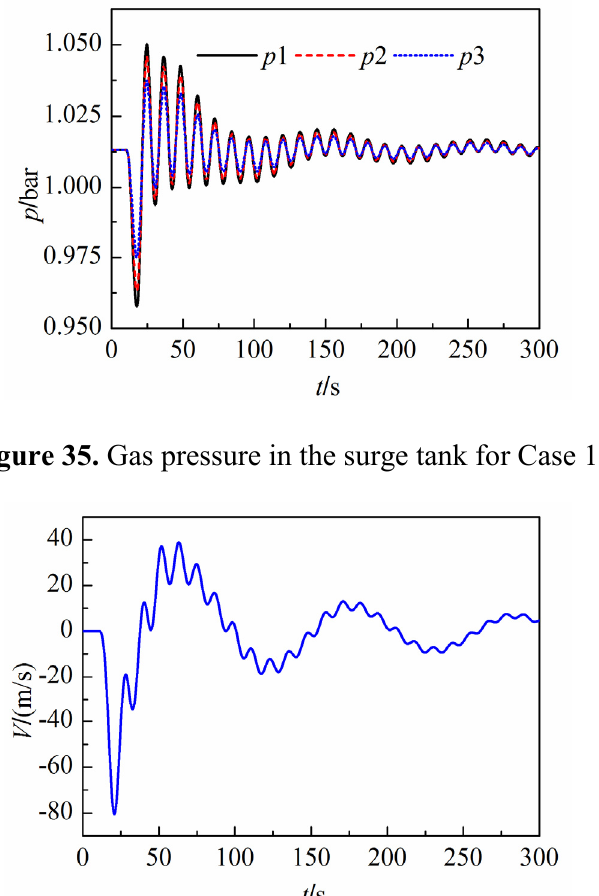
Figure 36. Wind speed at the outlet for Case